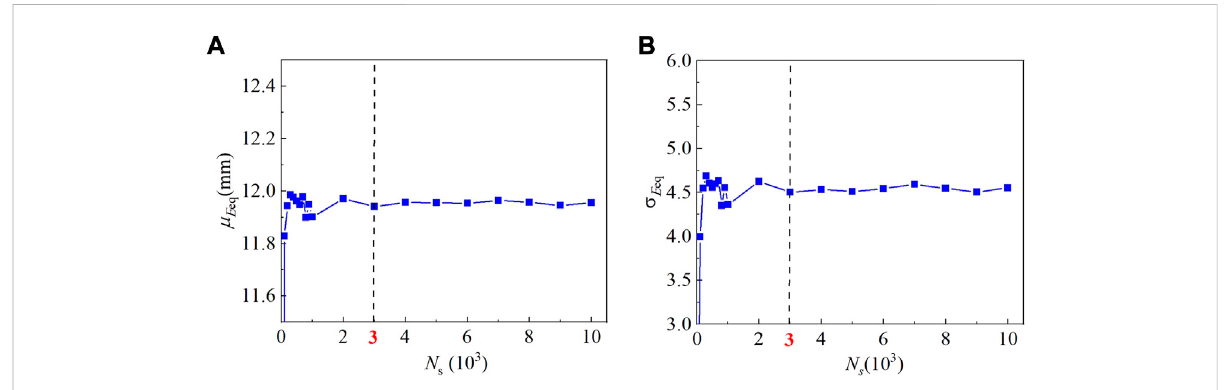
FIGURE 6 Variation of μ Eeq and σ Eeq with N s .